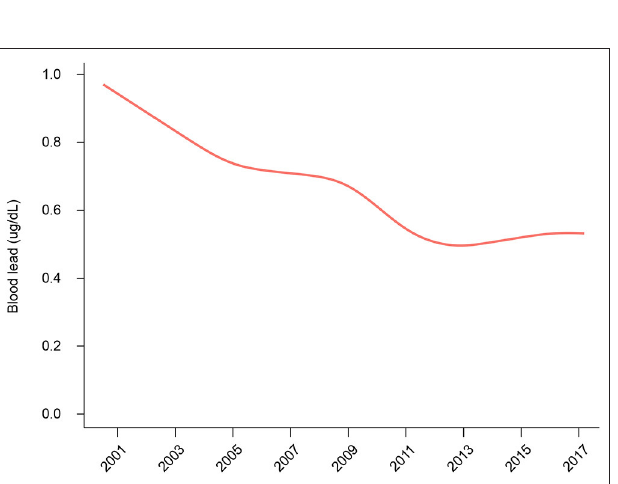
FIGURE 2 | The smoothed curve on the association between year cycle and blood lead